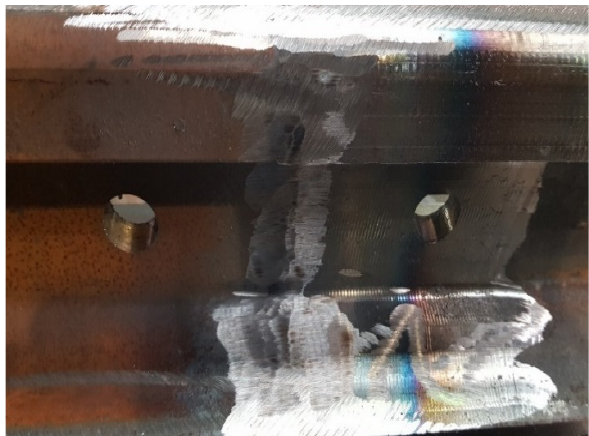
Figure 7. Scheme of checking the straightness of the joint in the horizontal plane: ( a ) convexity, ( b ) concavity. Source: own.